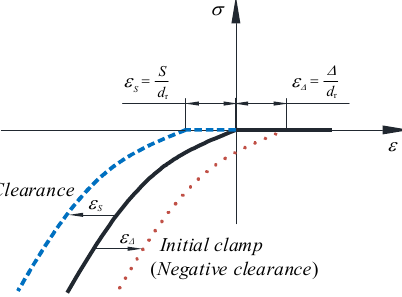
Figure 4. Stress-strain characteristics of the nonlinear spring element.